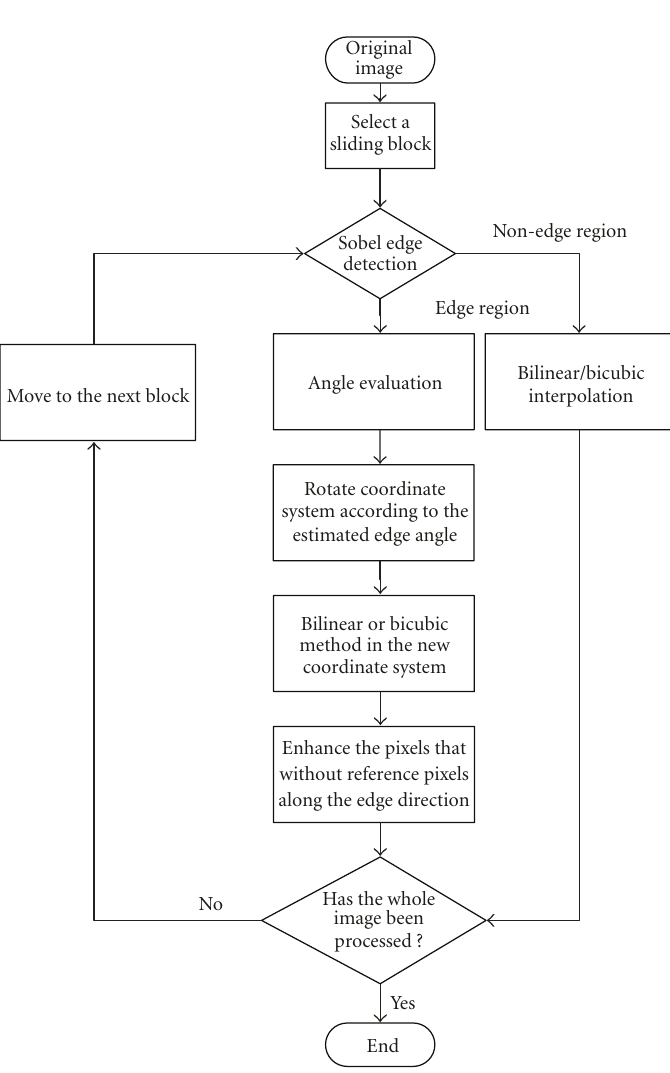
Figure 1: Schematic block diagram of the proposed image enlargement